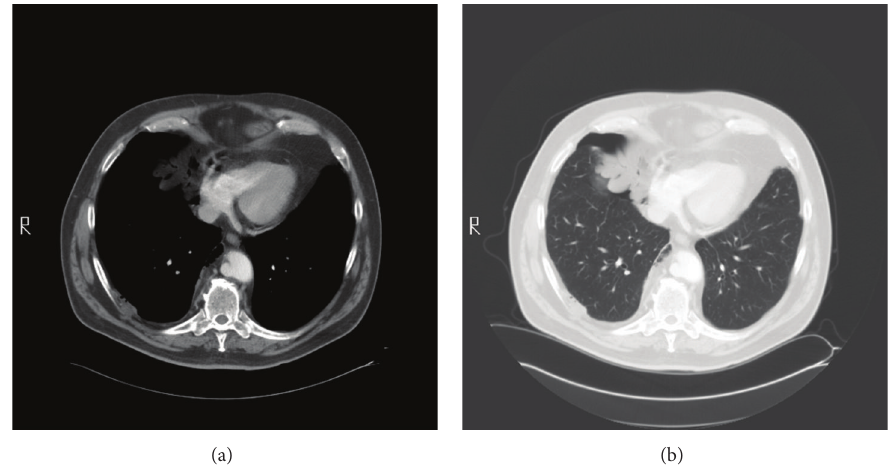
Figure 2: Chest CT scan in December 2007 showing a slightly larger anterior right pneumothorax. Corresponding soft tissue (mediastinal window view) showing that the soft-tissue mass adjacent to the pneumothorax is fat.